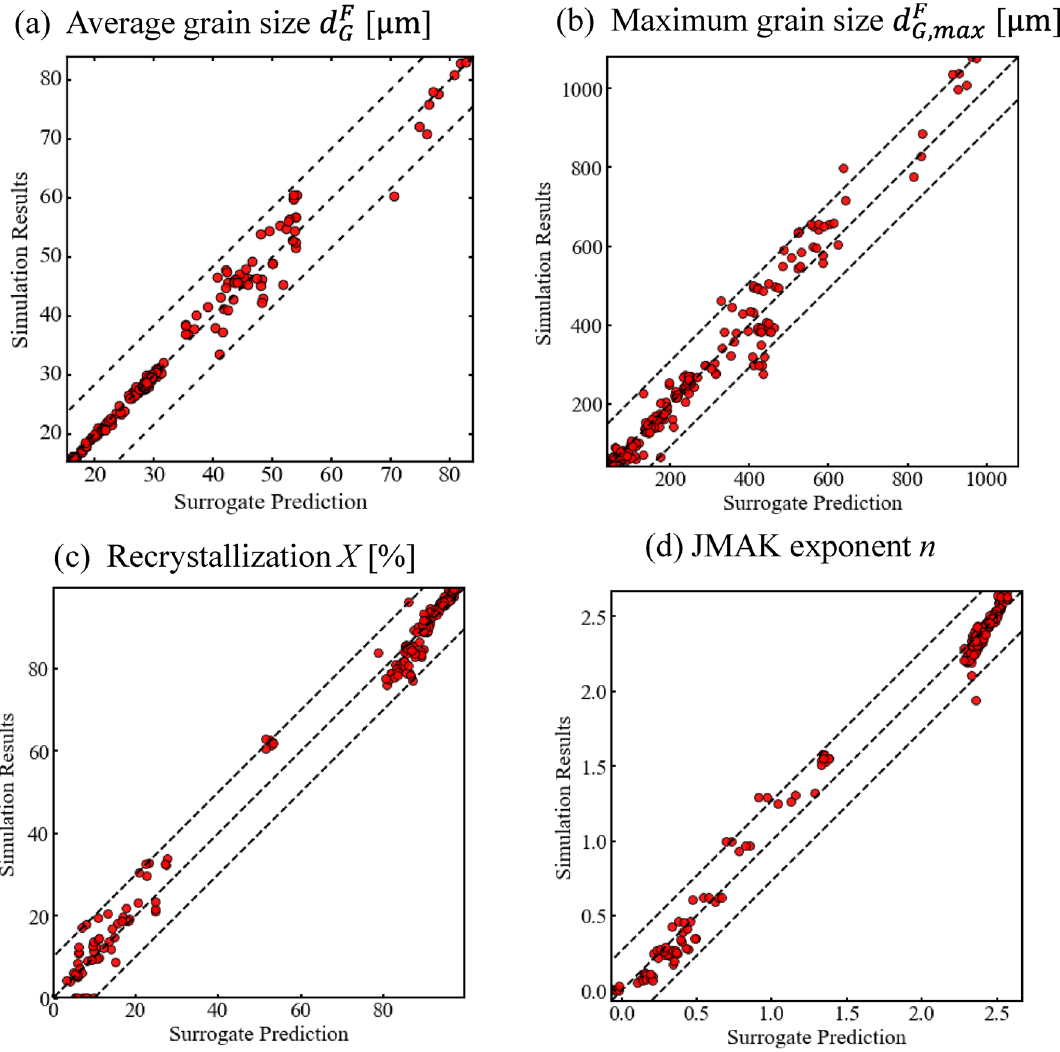
Figure 4. Comparison of stratified stacking ensemble model versus the FEM-Potts model simulations for the processed U-10Mo alloy ( a ) final averaged grain size d and ( d ) JMAK exponent n